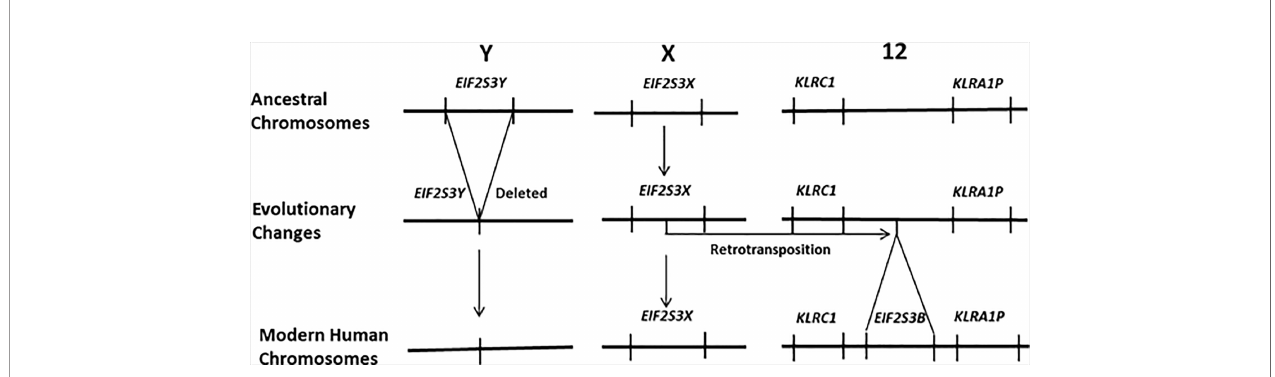
FIGURE 1 | In humans the EIF2S3Y gene has been deleted from the Y chromosome. It has been functionally replaced by a new gene that arose via a retrotransposition event that moved an intronless copy of EIF2S3X on to human chromosome 12 giving rise to the retrogene EIF2S3B . It is EIF2S3B that now regulates the initiation and maintenance of spermatogenesis in the human testis. Females carry four copies of the EIF2S3 gene. Each of the two X chromosomes contains a copy of EIF2S3X and two copies EIF2S3B located on the chromosome 12 pair within their genome. In contrast males possess only three copies of EIF2S3 within their genome. A single copy of EIF2S3X on the X chromosome and two copies EIF2S3B located on the chromosome 12